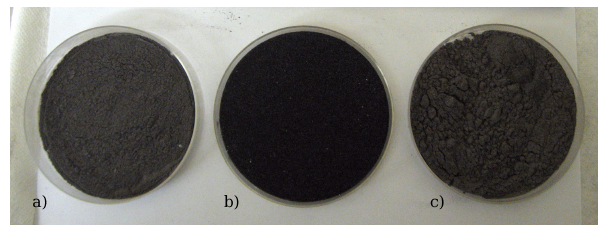
Figure 1. Samples of volcanic ash from the April–May (2010) Eyjafjallajökull volcanic eruption. (a) Original sample collected from the ground. (b) Fraction removed by sieving process (particles larger than 45µm). (c) Fraction re-suspended for analysis (particles smaller than 45µm).